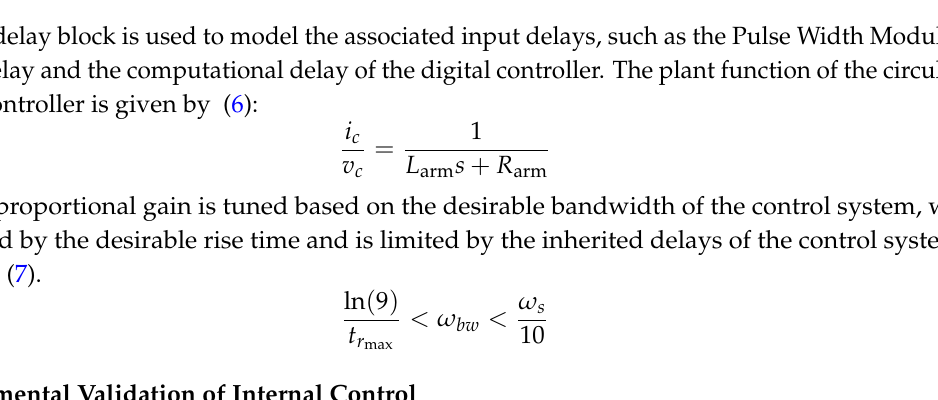
Figure 6. Circulating current